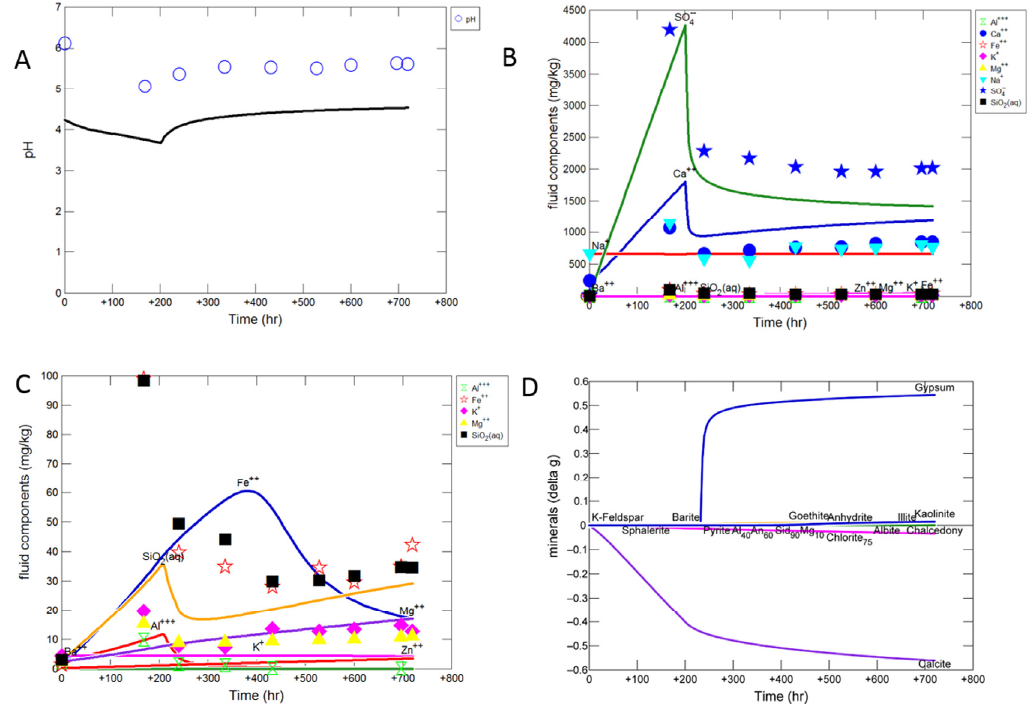
Figure 6. Modelled data as lines and experimental data shown as symbols for calcite cemented cap-rock reaction ( A ) Solution pH; ( B ) concentration of major ions; ( C ) concentration of minor ions; ( D ) predicted change in mineral mass in grams (g) where positive values indicate precipitation, and negative values dissolution. Note experimentally measured dissolved Si and S were converted to SiO 2 and sulphate for comparison to the modelled outputs, assuming all of the measured dissolved S was present as sulphate.